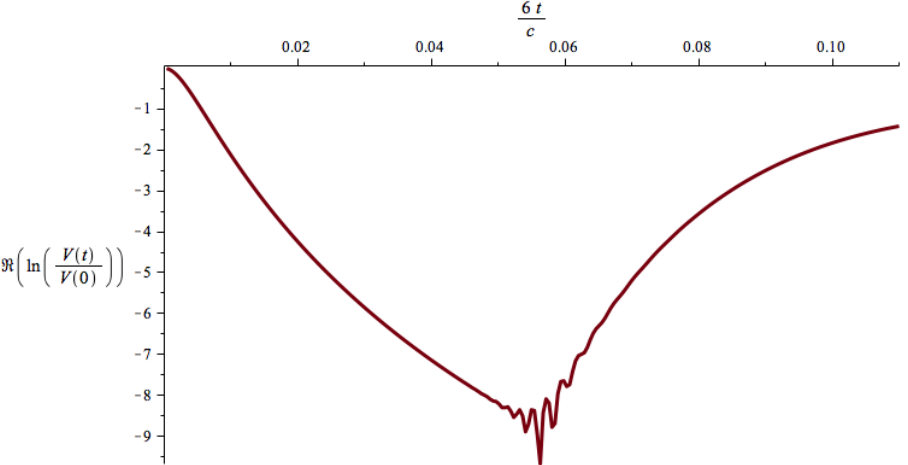
(cid:16) (cid:17) V hh 0 ( t ) versus V hh 0 (0)